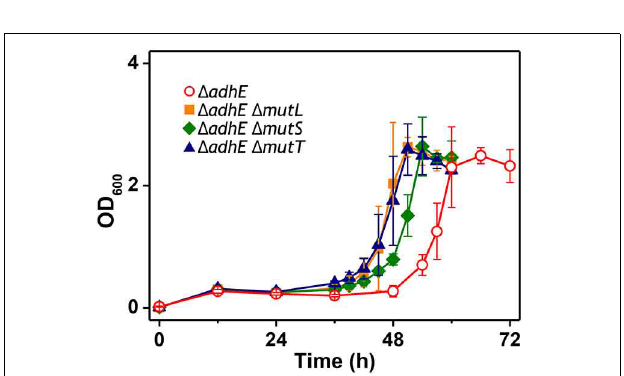
FIGURE 8 | Effect of mutator gene knockouts on anaerobic adaptation of BL21(DE3) (cid:2) adhE cells.